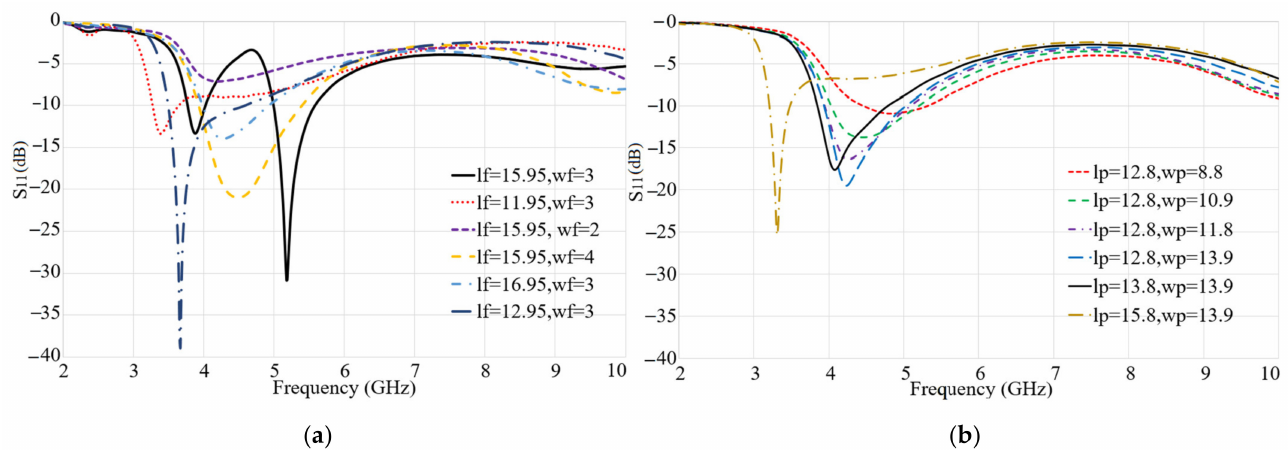
Figure 3. Parametric study of Antipodal Vivaldi Antennas (AVA) antenna: ( a ) lf (L f ): feed line length, wf (W f ): feed line width, ( b ) lp, and wp (L p , W p ) are the patch’s length and width (dimensions are given in